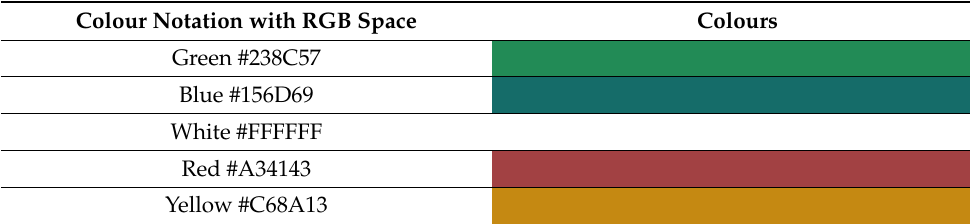
Table 4. Colour notation with RGB space was adopted in this study